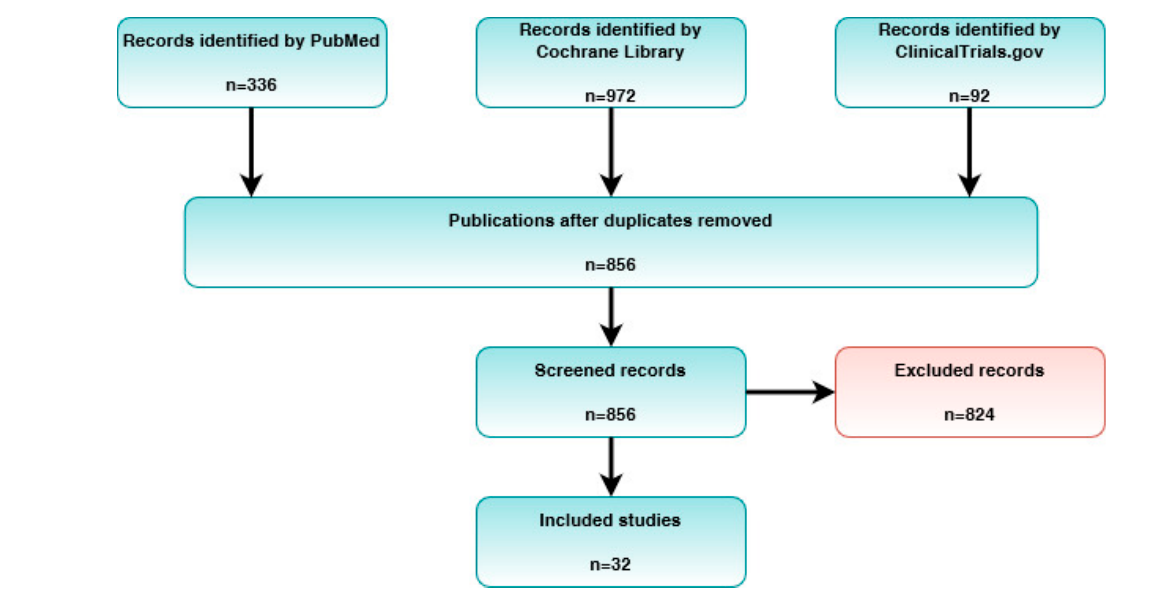
Figure 2. PRISMA flowchart of the study selection process. Table 1. Characteristics of the clinical studies included in the analysis.